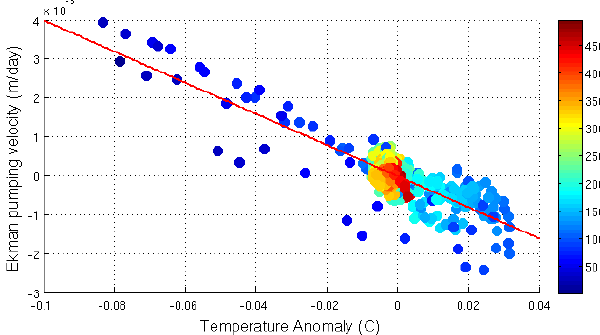
Relation between the Ekman pumping vertical velocities ( w EK ) and T' . The color code represent the distance from the eddy center (km), showing that the linear relation between these two fields is stronger closer to the eddy core, as demonstrated by the linear regression illustrated by the red line.